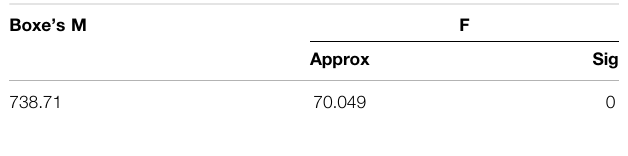
TABLE 3 | Box ’ s M test results of equality covariance